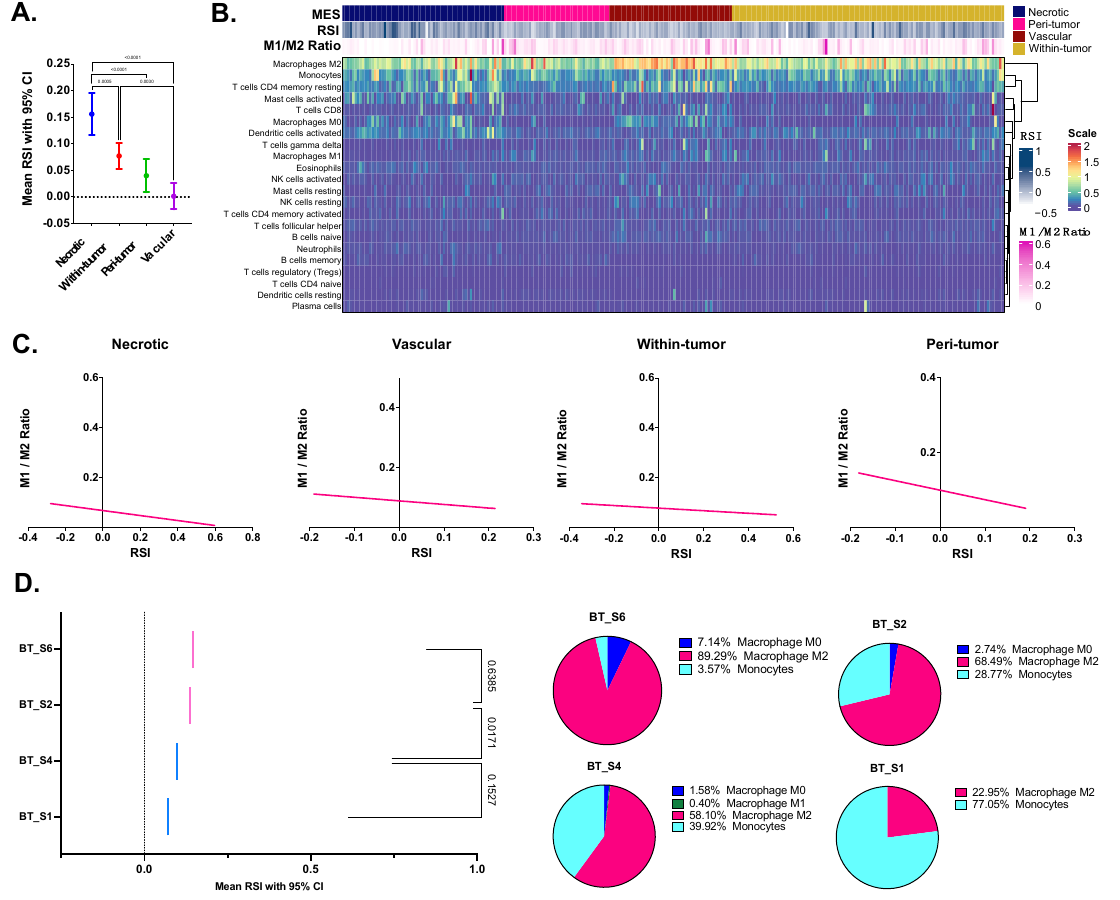
Figure 2. ( A ) In the Ivy Glioblastoma Atlas Project dataset, RSI was compared between anatomic MES in the tumor microenvironment. p -values, estimated by one-way analysis of variance (ANOVA), are shown in the graph. ( B ) Heatmap representing immune cells deconvoluted by the CIBERSORTx algorithm and RSI according to anatomic MES. ( C ) Scatter plots showing RSI and M1/M2 macrophage ratio according to anatomic MES. Fitted line (sold) and its 95% CI error (dotted) is shown in each plot. ( D ) In a single-cell RNA sequencing dataset (GSE84465), mean RSI with 95% CI are estimated from collection of single cells in each study patient. p -value was estimated by ANOVA. In the right panel, pie charts are demonstrated with respect to proportion of macrophages. Abbreviations: CI, confidence interval; M1, M1 macrophage; M2, M2 macrophage; RSI, radiosensi- tive index; MES, microenvironment structures.